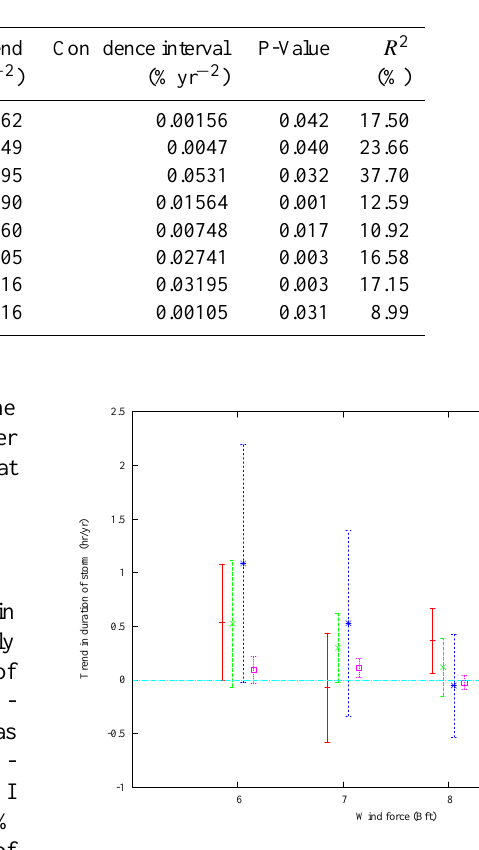
Table 2. Significant trends in the yearly frequency of occurrence for the difference in wind forces. vlra: Vlakte van de Raan; bhg2: Brouwershavensegat 2; whid: Westhinder DNMI data. R 2 : coefficient of determination.